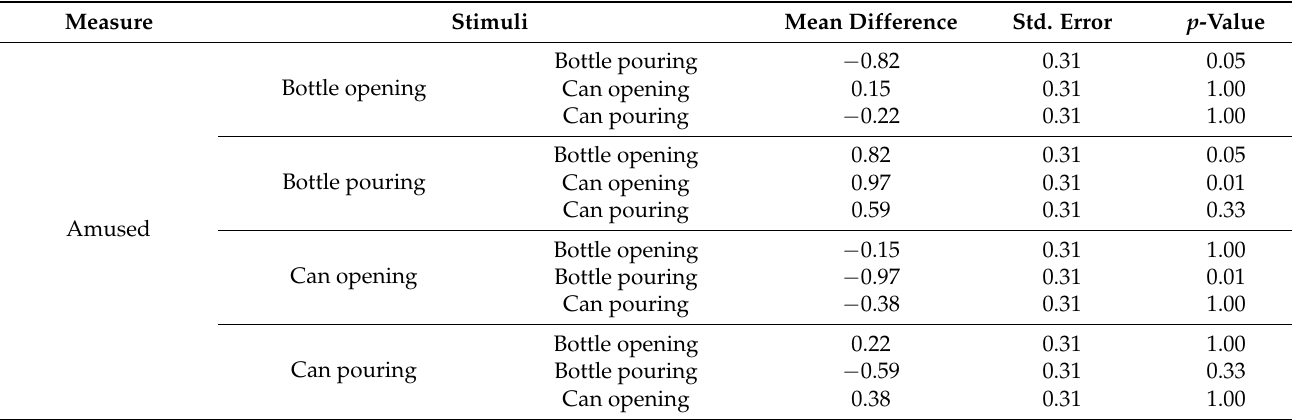
Table A2. Summary of the results of the pairwise comparisons of Experiment 1 between-participants condition (sounds of packaging auditory experience) for emotion